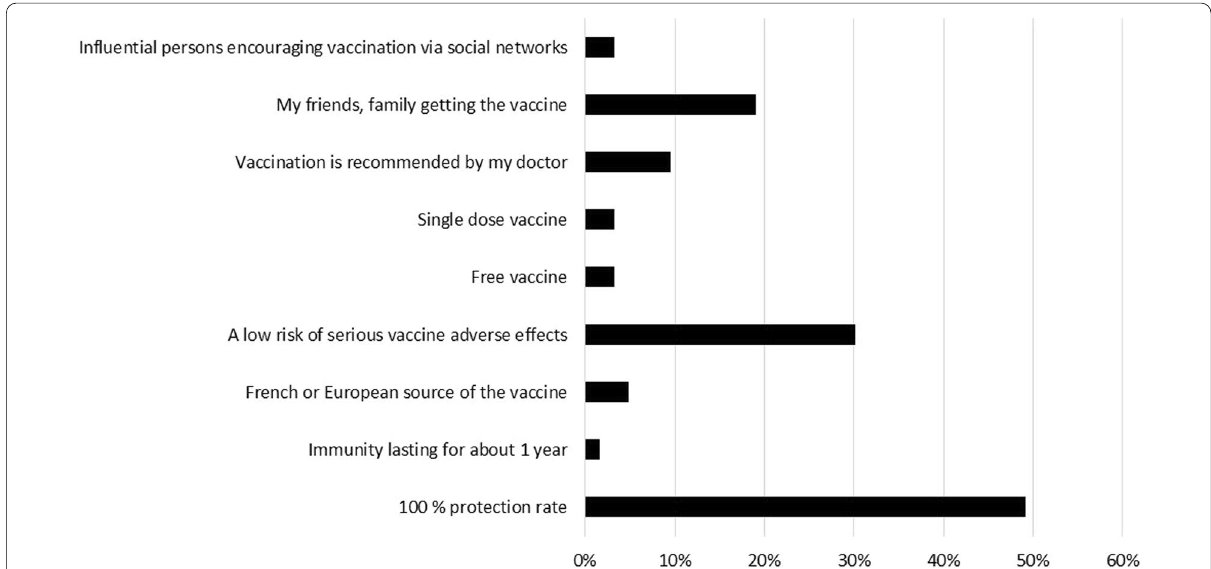
Fig. 4 Reasons for change towards intention to get COVID-19 vaccination among vaccine hesitant group [ n